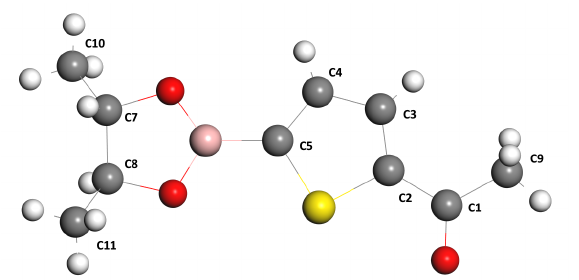
Figure 6. Label of the carbon atoms of the structure of the C 10 H 13 BO 3 S compound.